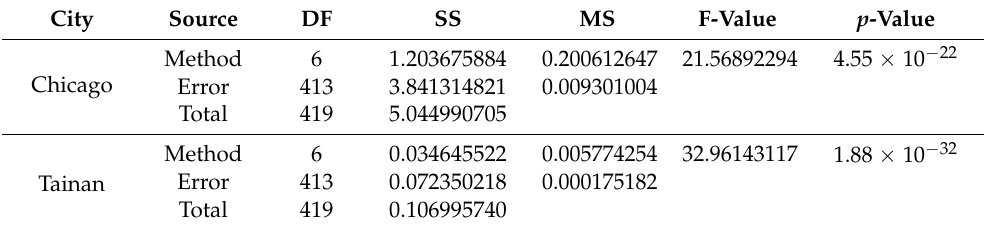
Table 9. One-way ANOVA test for different methods and constraints towards unit PF performance.